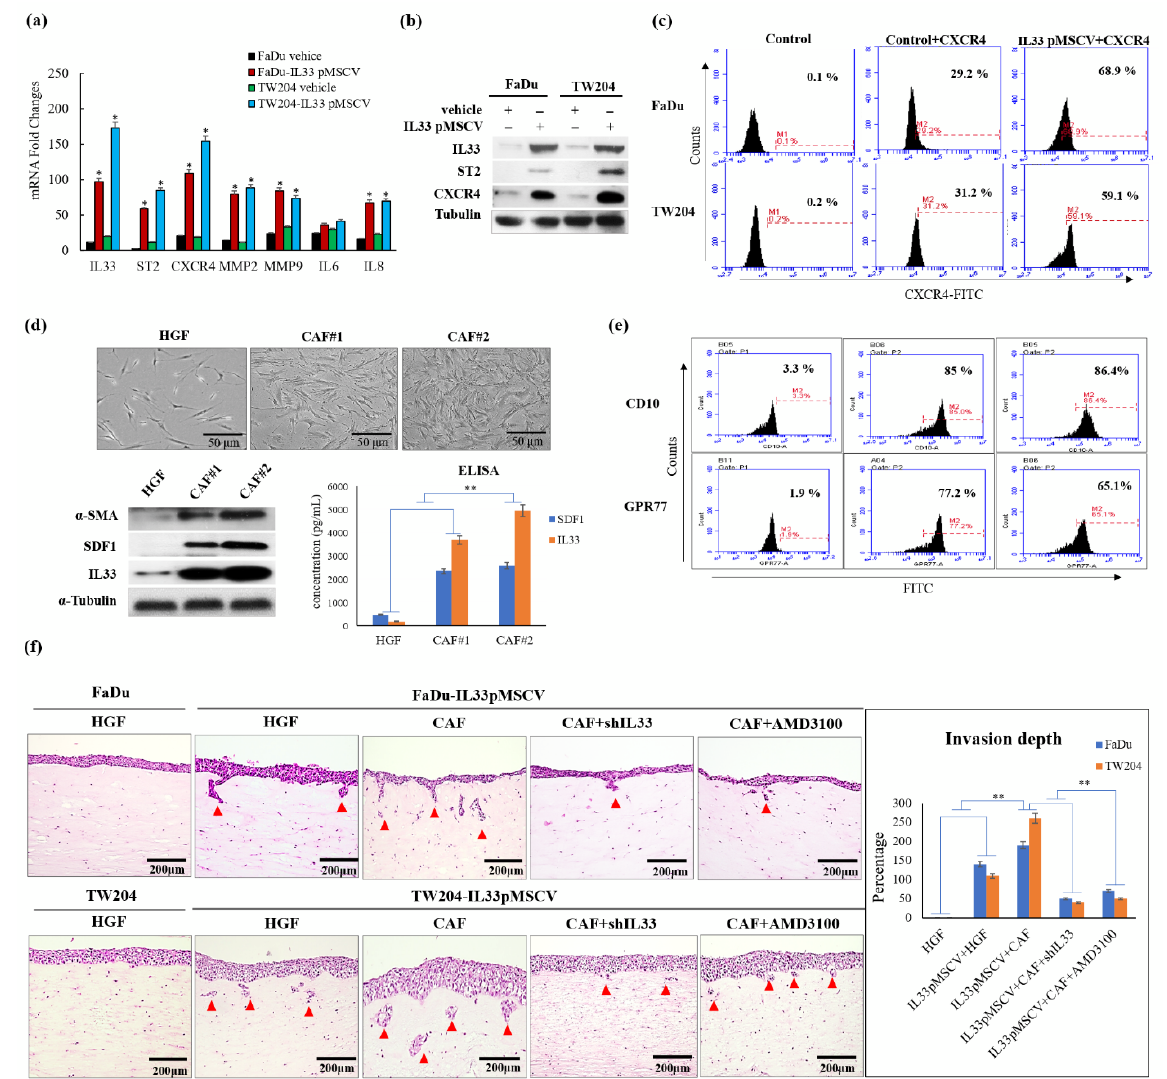
Figure 1. Comparative analysis and characterization of CAFs and HGFs and their effects on two stable clones of the IL-33-overexpressing HNSCC cells and control HNSCC cells. ( a ) Besides the upregulation of IL-33, ST2, and CXCR4, the expressions of two representative invasion biomarkers, MMP2 and MMP9 by RT-PCR, were enhanced statically, in the cloned IL-33-overexpressing HNSCC cells compared to in the control HNSCC cells. ( b ) Western blotting analysis showed higher expressions of ST2 and CXCR4 in the cloned IL-33-overexpressing HNSCC cells than in the control HNSCC cells. The uncropped Western blots have been shown in Figure S2. ( c ) Flow cytometry revealed higher expressions of CXCR4 in the cloned IL-33-overexpressing HNSCC cells than in the control HNSCC cells. ( d ) The top panel shows the phenotypic differences between the CAFs and HGFs. The Western blotting analysis showed that the expressions of SDF-1 and IL33 in two representative CAFs were statistically higher than that in HGFs ( p < 0.05) with further validation by ELISA shown at the bottom panels. ( e ) Flow cytometry demonstrated that the CAFs displayed higher expressions of CD10 and GPR77 than the HGFs. ( f ) Four test groups and one control group were classified for a comparative analysis of invasive ability via organotypic culture. The induction of invasion (shown by arrows) demonstrated that there were many foci of the infiltrated cells in the IL-33-overexpressing stable clones, which were markedly enhanced by the CAF-induced IL-33 (in upper and lower center panels). However, in the control group and one test group wherein the IL-33-overexpressing stable clones were cultured without the CAF-induced IL-33, no obvious invasion induction or decreased invasion induction was seen (left two upper and lower panels). The blockade of the IL-33 via shIL-33 or by using an inhibitor of CXCR4 (25 µ g/mL AMD3100) markedly decreased the invasion ability (right upper and lower two panels). The statistical analysis of tumor invasion depth is shown in the right panel. * p < 0.05; ** p <